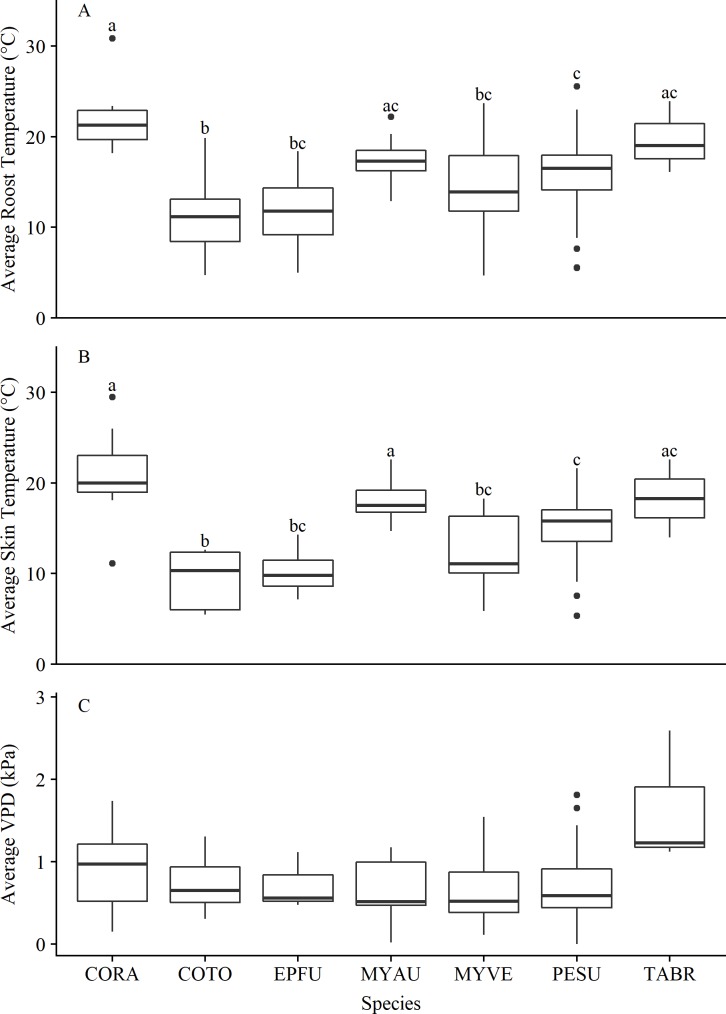
Box and whisker plots of average roost temperature, average skin temperature, and vapor pressure deficit for seven bat species.Box and whisker plots displaying the median, and upper (75%) and lower (25%) quartile range of (A) average roost temperatures, (B) average skin temperatures, and (C) average vapor pressure deficit (VPD) collected between November–March 2016–2017 and 2017–2018 in Texas for the following seven bat species: Rafinesque’s big-eared bat (Corynorhinus rafinesquii = CORA), Townsend’s big-eared bat (C. townsendii = COTO), big-brown bat (Eptesicus fuscus = EPFU), southeastern myotis (Myotis austroriparius = MYAU), cave myotis (M. velifer = MYVE), tri-colored bat (Perimyotis subflavus = PESU), and Mexican free-tailed bat (Tadarida brasiliensis = TABR). Significant differences between groups (P ≤ 0.05) are distinguished by letters. Filled circles indicate outliers.